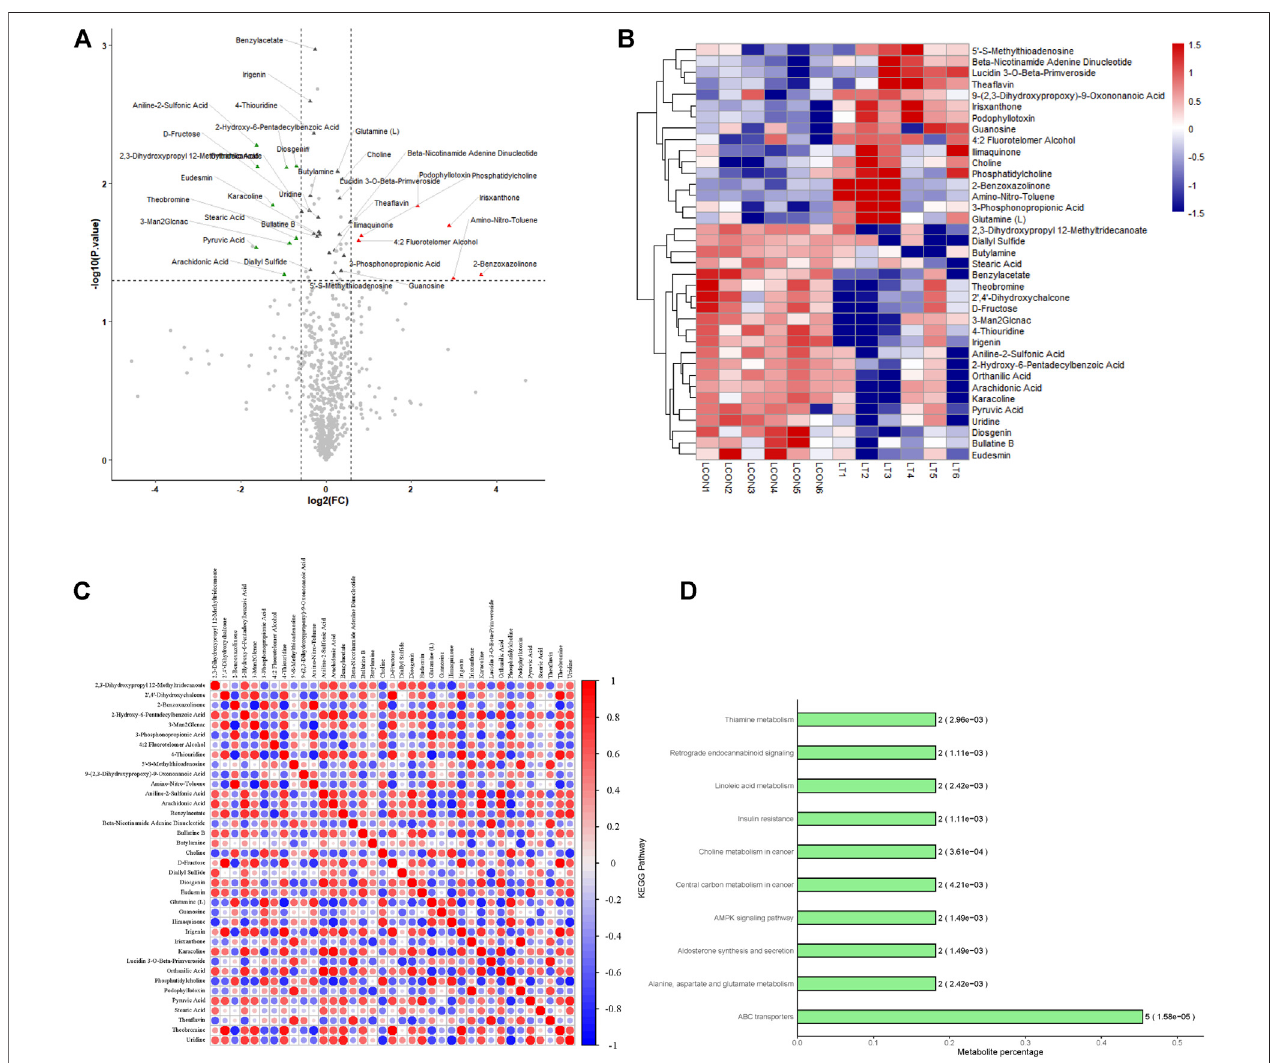
FIGURE 2 | Identi fi cation and analysis of differentially expressed metabolites. (A) Volcano plots presenting the metabolites differences between two groups; red plots represent signi fi cantly upregulated metabolites and green represents downregulated metabolites. (B) Heat map shows the metabolites clustering results in two groups (red represents upregulated proteins and blue represents downregulated proteins). (C) Heat map of the correlation coef fi cient matrix demonstrated the correlations between the signi fi cant metabolites. (D) Metabolites obtained in the comparison group were enriched in the KEGG metabolic pathway.